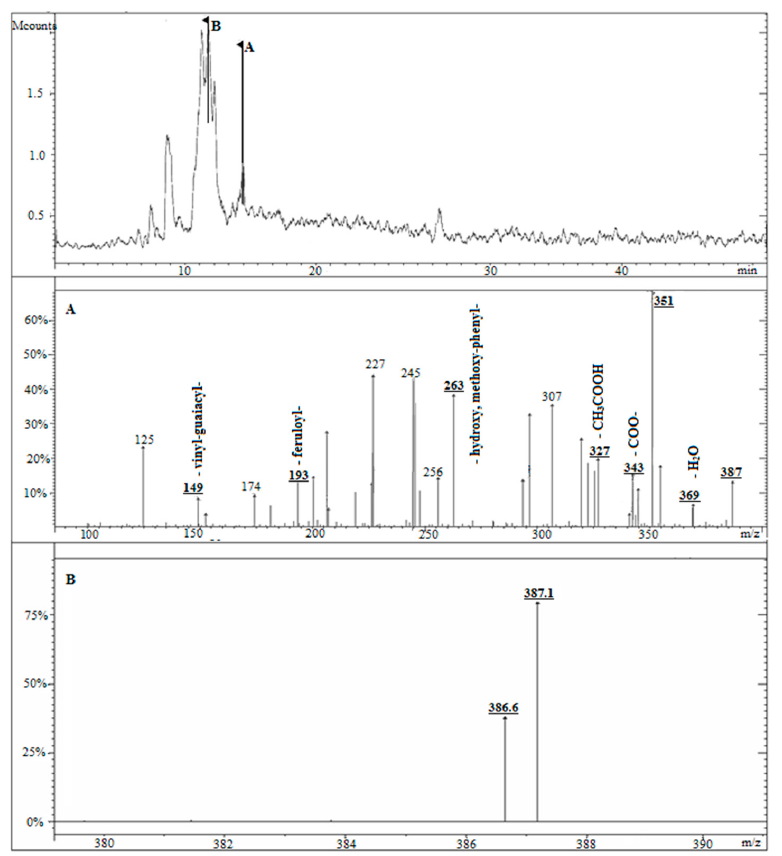
Figure 6. Liquid chromatography mass spectrometry (LCMS) and MS/MS spectra of diferulic compounds in arabinoxylan gel. ( A ) MS fragmentations of peak A. ( B ) MS fragmentations of peak